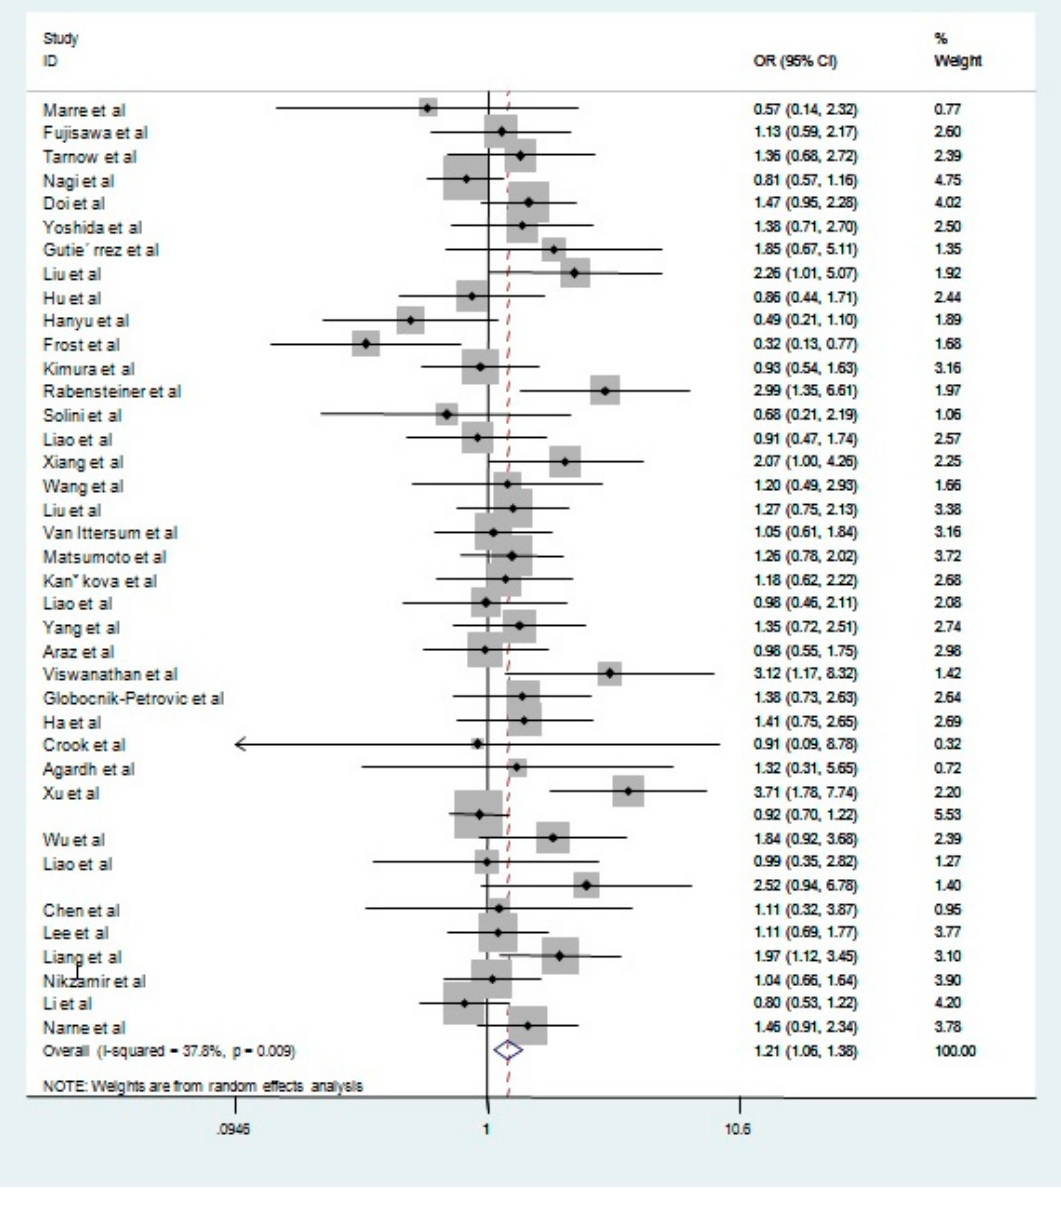
Figure 2. ORs (log scale) of DR associated with ACE I/D polymorphism for dominant genetic model. The graph shows individual and pooled estimates for all studies.